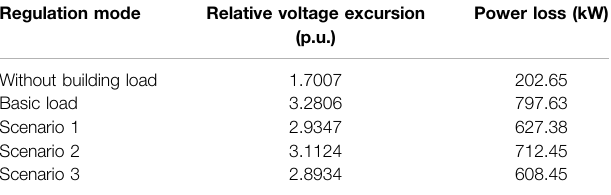
TABLE 1 | Indices under different scenarios for the load peak at 19:00. Regulation mode